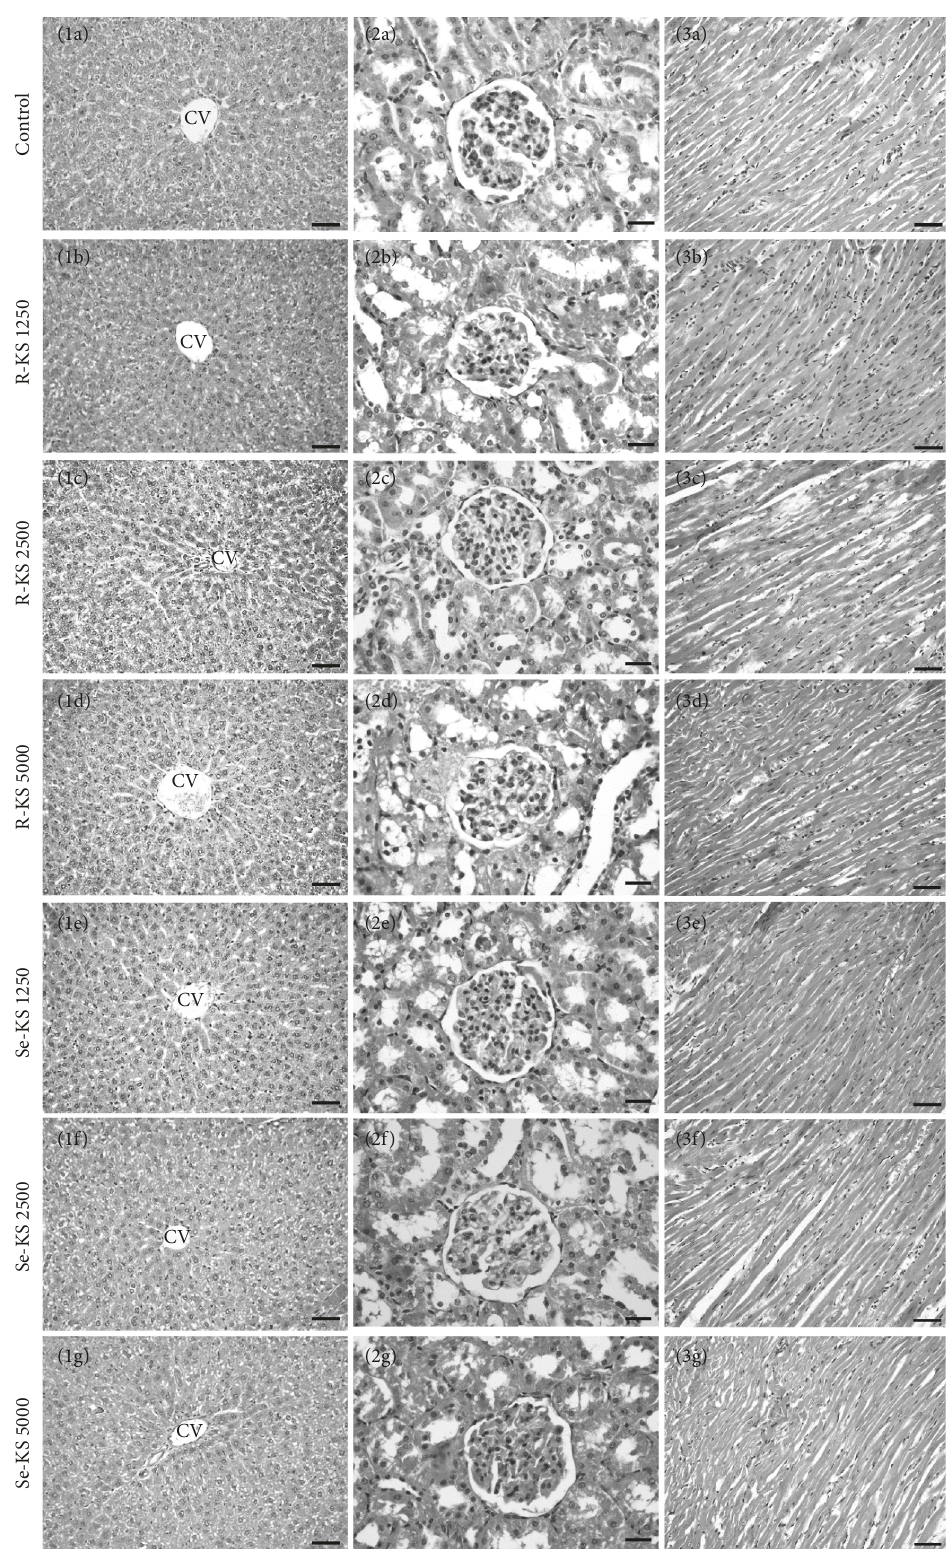
Figure 3: Histopathological analysis of organs treated with control (vehicle), regular Chinese kale seedlings (R-KS), and Se-enriched Chinese kale seedlings (Se-KS) at 1250, 2500, and 5000mg/kg · b.w. Column 1 (liver), scale bar is 50 µ m (CV is central vein); column 2 (kidney) glomerulus, scale bar is 20 µ m; and column 3 (heart muscle), scale bar is 50 µ